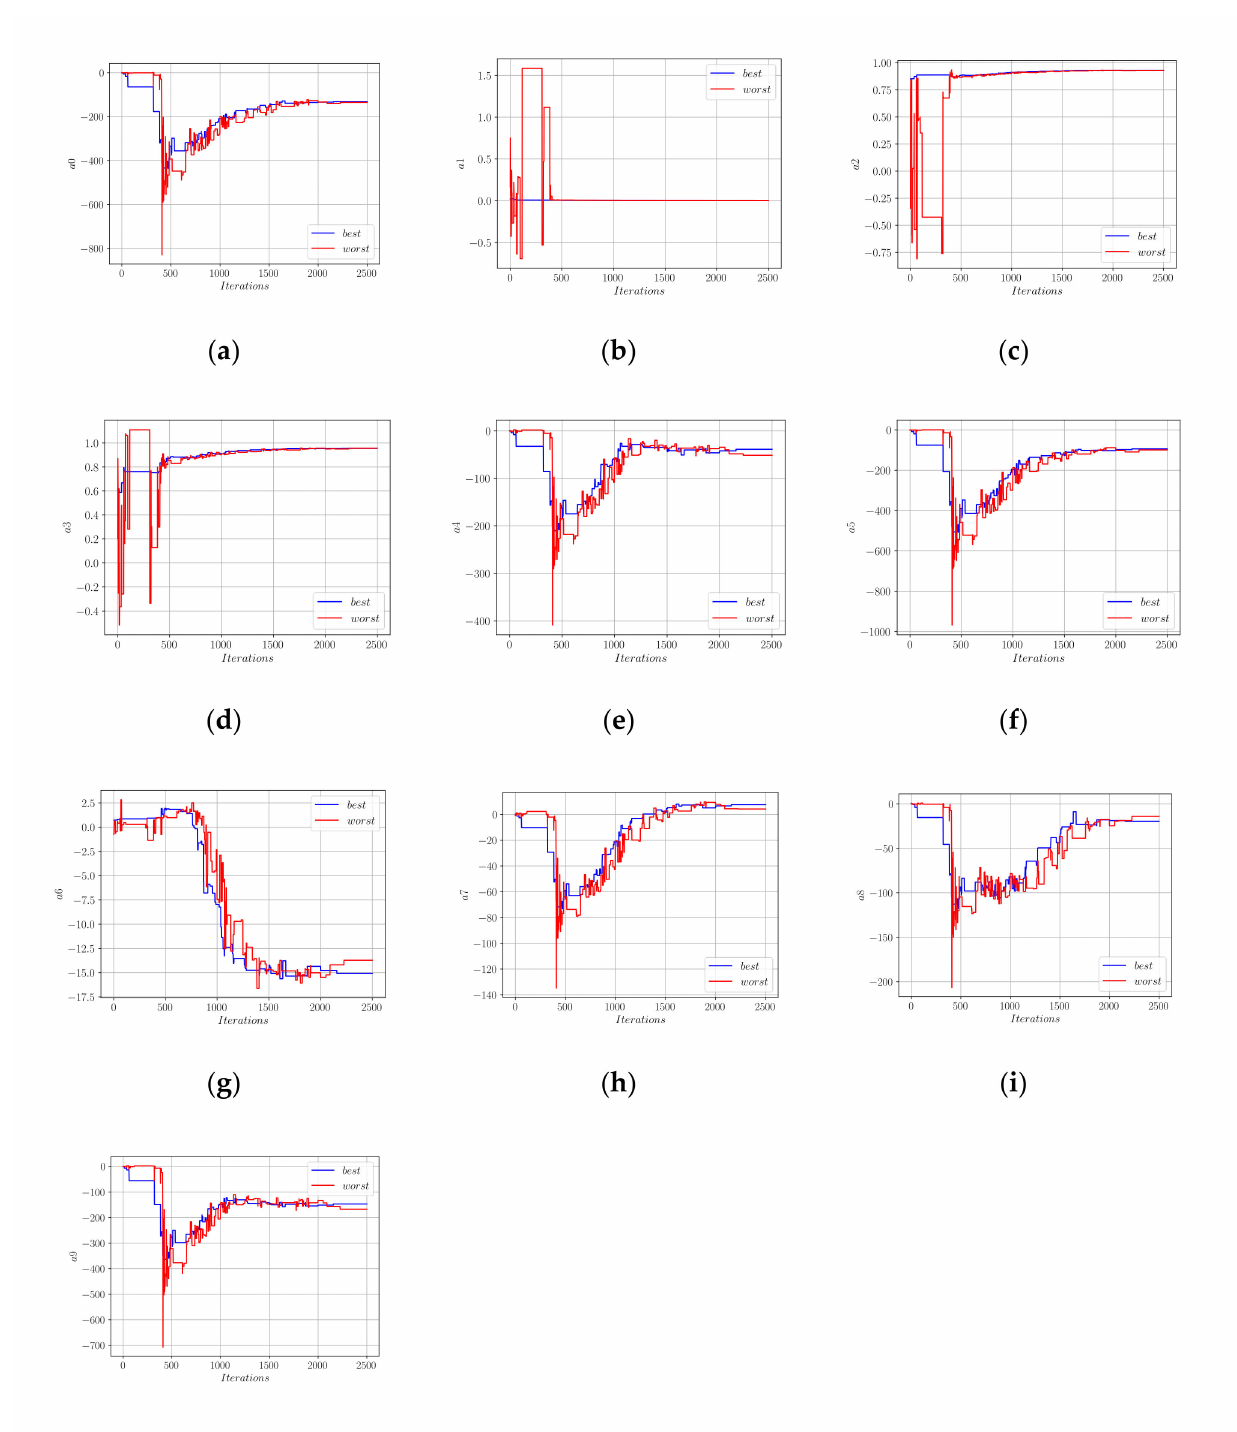
Figure 10. Development of the coefficients in Equation (20); ( a ) a 0 ; ( b ) a 1 ; ( c ) a 2 ; ( d ) a 3 ; ( e ) a 4 ; ( f ) a 5 ; ( g ) a 6 ; ( h ) a 7 ; ( i ) a 8 ; ( j ) a 9